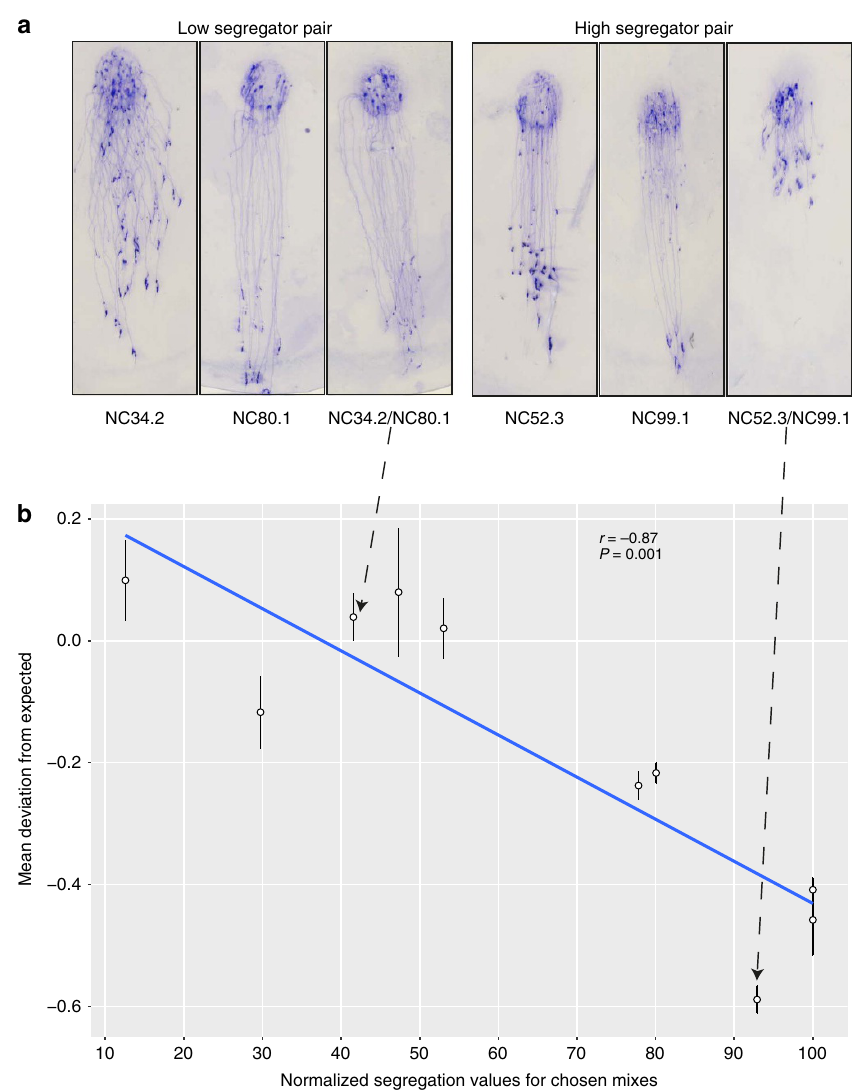
Figure 3 | Strains with higher segregation values exhibit reduced slug migration. ( a ) Representative slug trail images from clonal and chimeric pairs showing low (41%) and high segregation (93%). The circular area at the top represents the spot where cells were initially plated and is the point of origin of the slug trails. Slugs were allowed to form and migrate toward a unilateral light source at the bottom of the dish over a period of 30h before the trails were transferred from the surface of the agar onto a PVC disc and then stained with Coomassie Brilliant Blue. ( b ) Slug migration distances across ten different pairwise strain combinations. The mean migration distances were calculated for each clone and chimeric mix from four replicates (error bars depict s.e. of these four replicates). Expected chimeric values for each pair were then calculated as an average of the slug migration of each clone in the mix. Slug migration values are expressed as a deviation from these expected values. Mean slug migration distances of the high segregating pairs ( 4 90%) are significantly shorter (Pearson’s product moment correlation; r ¼ 0.87, P ¼ 0.001) than the expected migration distances based on the slug migration of the two respective clones in